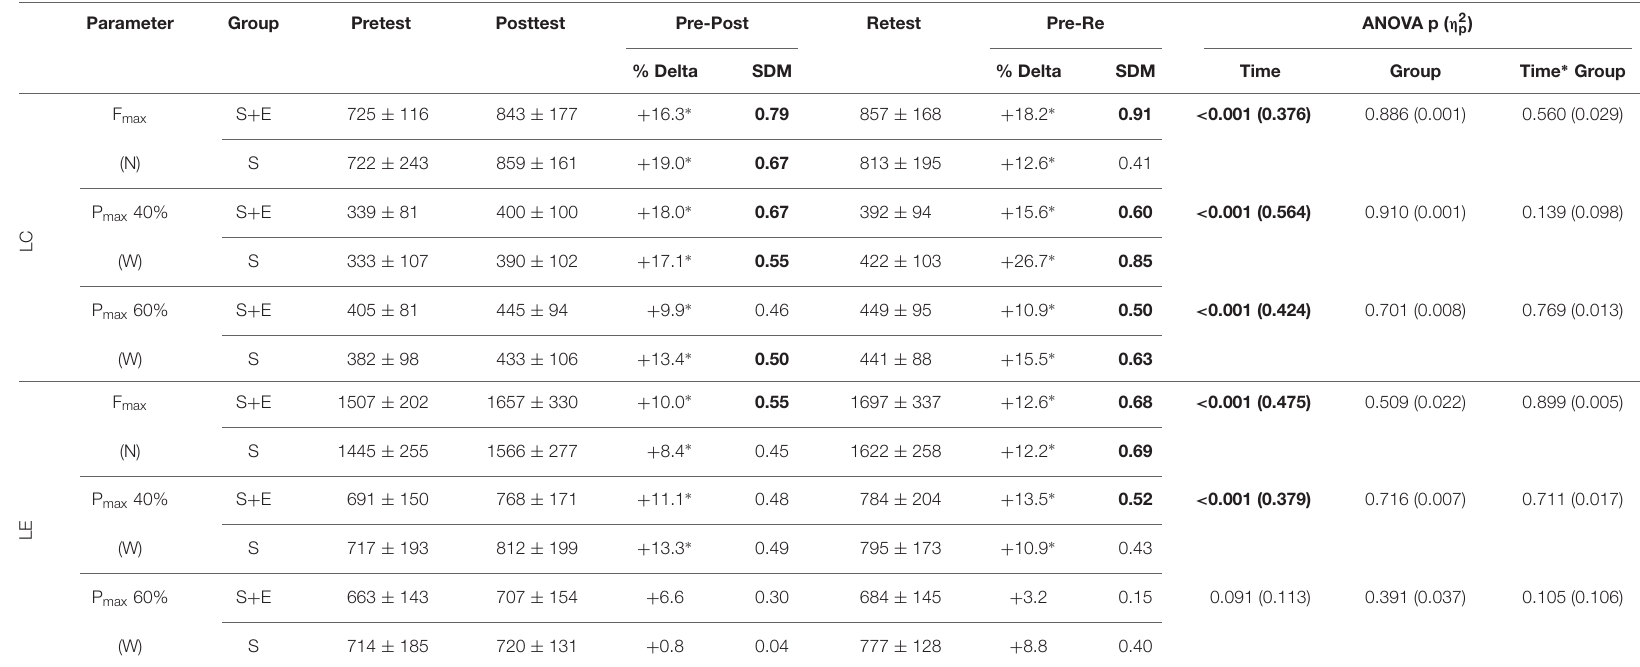
Values are presented as mean ± SD. Moderate to large standardized mean differences (SMD) have been highlighted in bold. Significance level for time effects for both groups to pretest was set at p ≤ 0.05 ∗